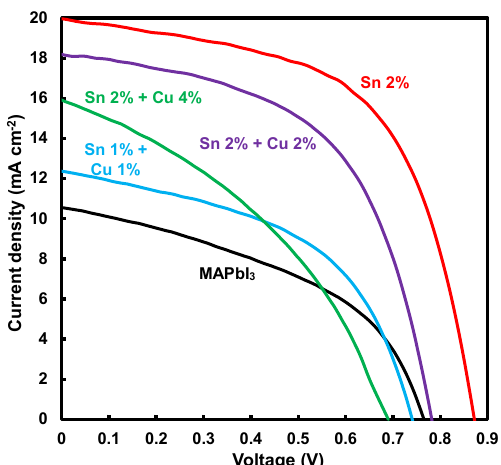
Figure 4. J-V characteristics of each device with the best efficiency for the time course. Perovskite solar cells without FA and DPPS layer were also investigated, and the photovoltaic parameters are listed in Table 5. The compositions of the perovskite com- pounds were CH 3 NH 3 Pb 0.95 Sn 0.05 I 3 and CH 3 NH 3 Pb 0.9 Sn 0.05 Cu 0.05 I 3 , which are denoted as Sn 5% and Sn 5% + Cu 5%, respectively. Since there was no DPPS layer, the annealing temperature of the perovskite layers was 140 ◦ C for 10 min. For the Sn-added device, both η and J SC increased after 115 days, which agreed with the results of Figure 3, indicating the effectiveness of Sn